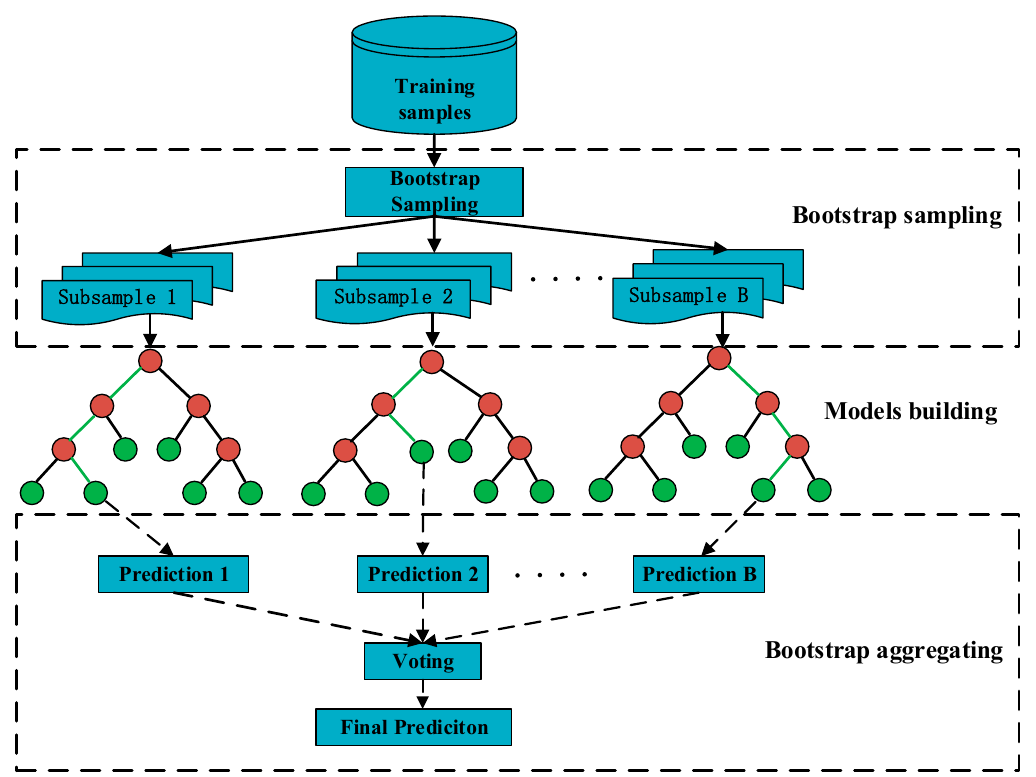
Figure 3. The scheme of random forest algorithm. The final prediction is obtained by taking a majority vote of the predictions from all the trees in the forest.